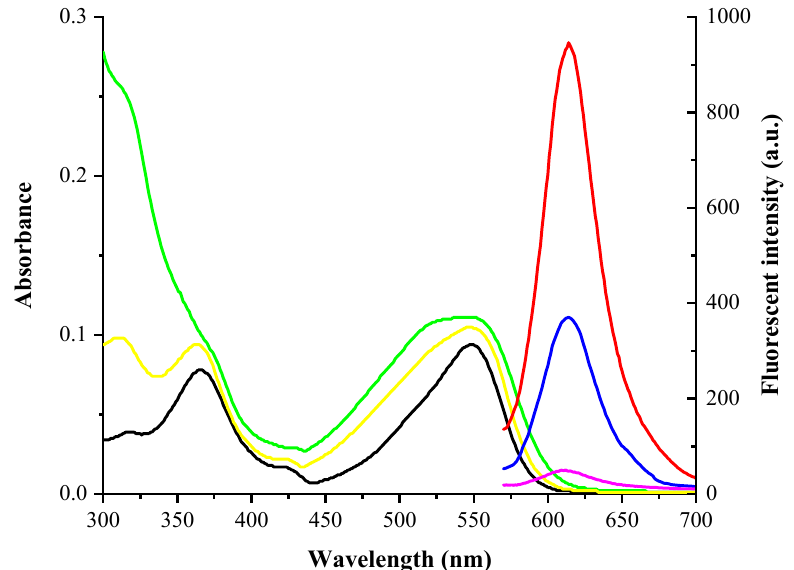
Figure 1. Absorption spectra of 10 µ M YZ-A3 (black) and YZ-A4 (green), and treating YZ-A4 with 10 µ M Sec (yellow) in PBS (10 mM, pH 7.40, containing 1% DMSO as cosolvent). Fluorescence spectra of 10 µ M YZ-A3 (red), and YZ-A4 before (pink) and after (blue) reaction with 10 µ M Sec in PBS (10 mM, pH 7.40, containing 1% DMSO as cosolvent), excited at 550 nm.